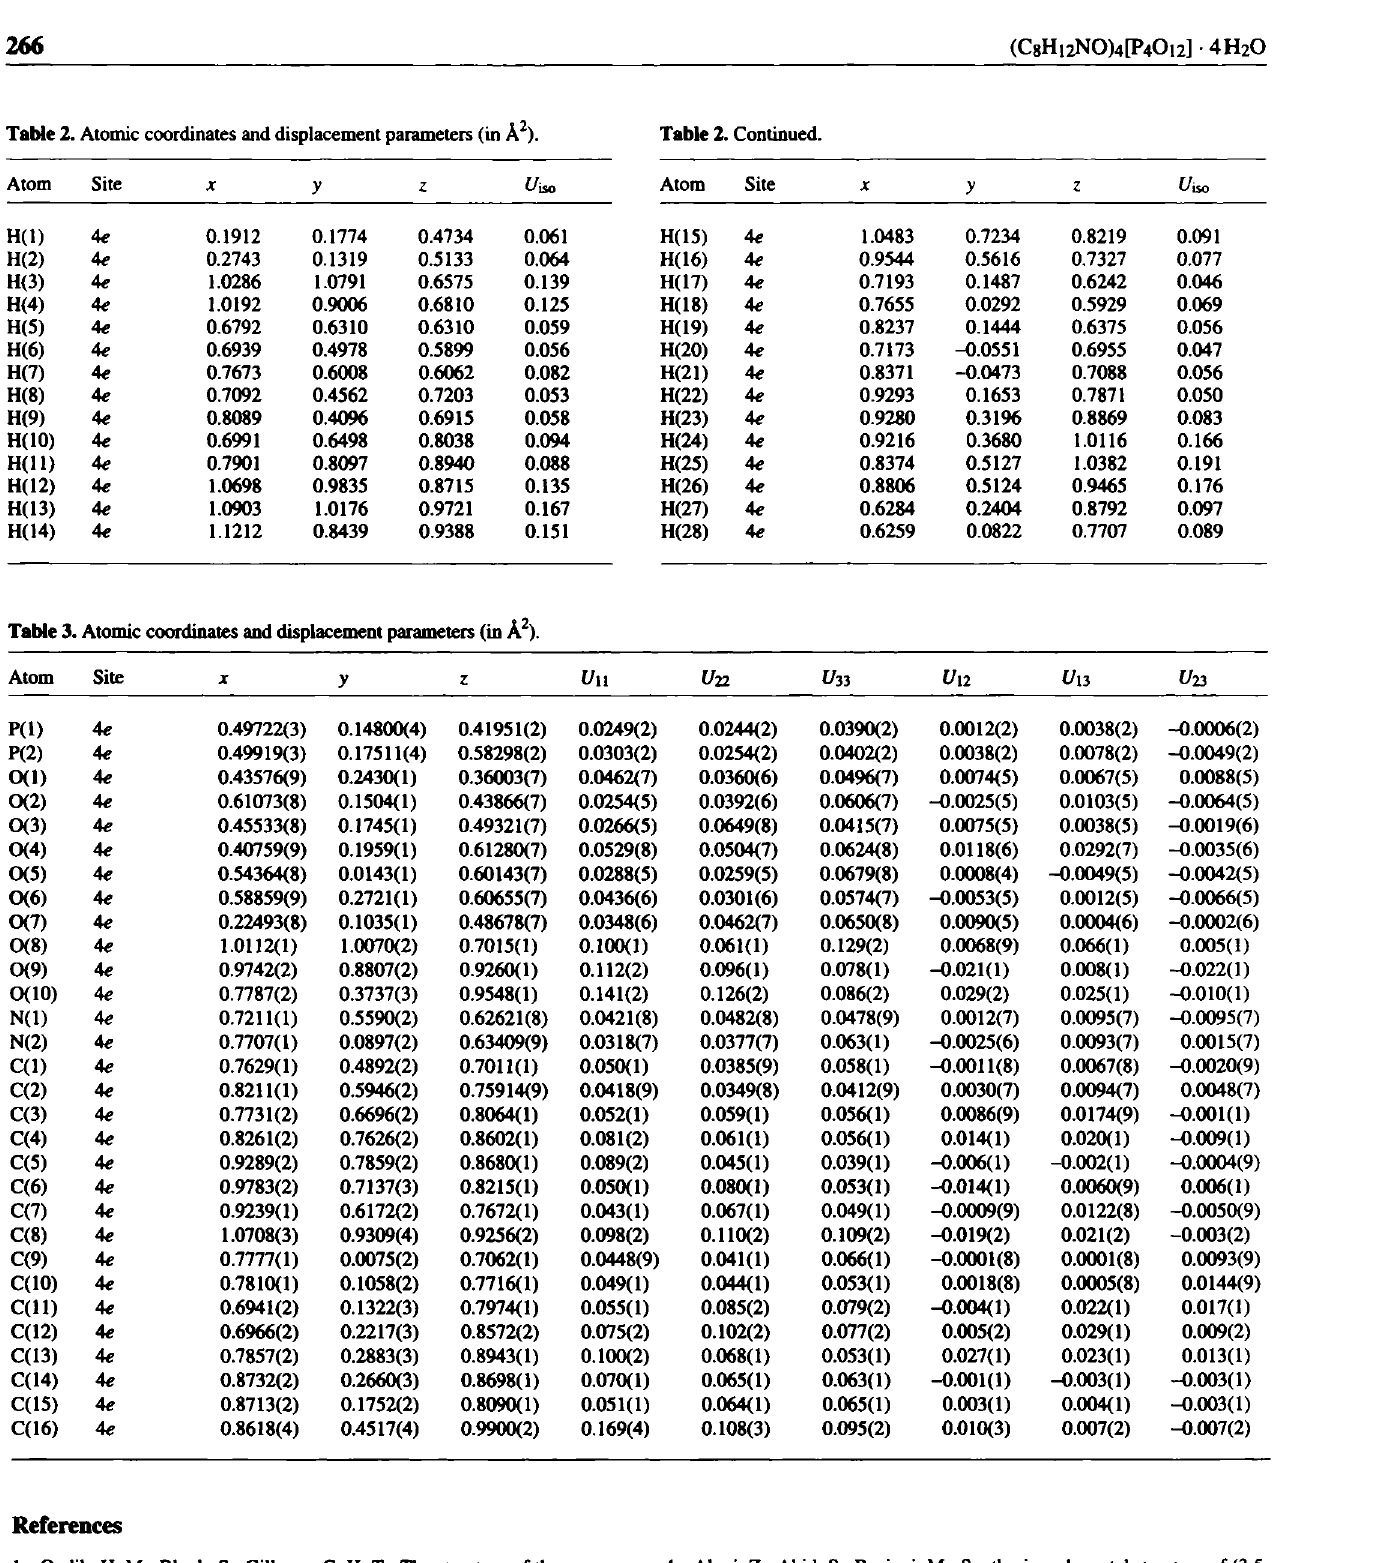
Tabic 2. Atomic coordinates and displacement parameters (in Ä 2 ).